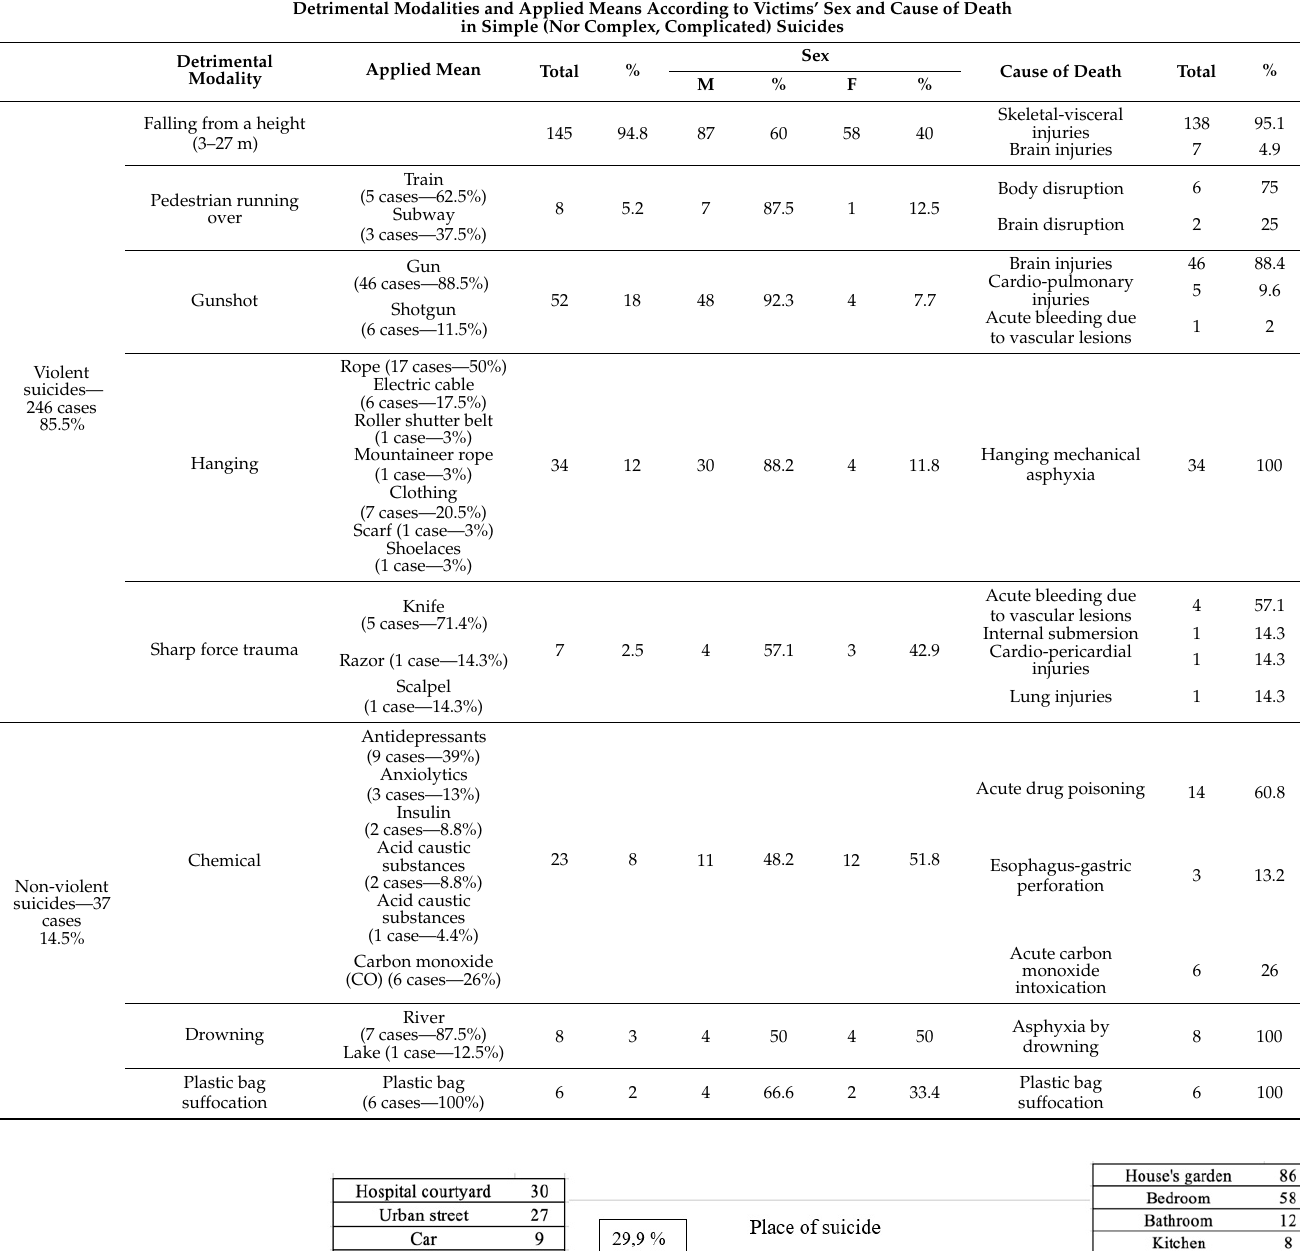
Table 4. Details of violent and non-violent suicides.